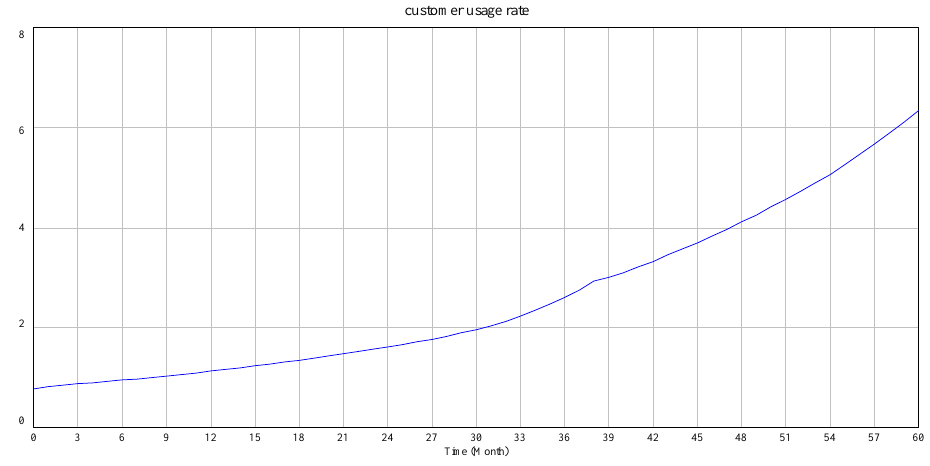
Figure 4. Customer usage rate.